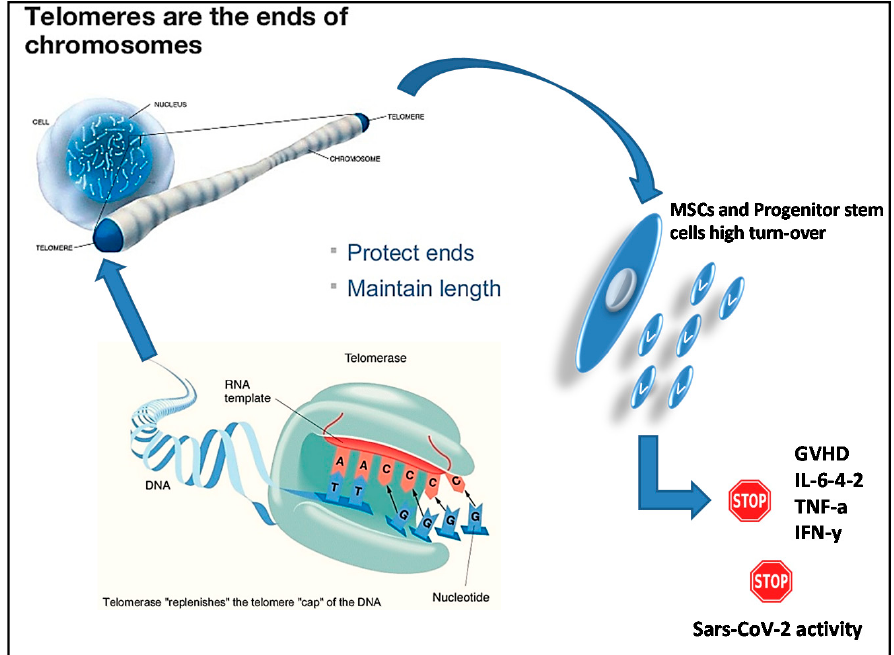
Figure 2. Hypothesis linking telomere length and replicative capacity of MSCs to autoimmune pathophysiology in contrasting SARS-CoV-2 aggression in young adults and children. The image indicates how telomere is a key factor in sustaining the replicative capacity of individual MSCs population doublings which then activate their immune modulation property against the inflammatory process lead by IL-6, TNF- α , IFN- γ triggered by the